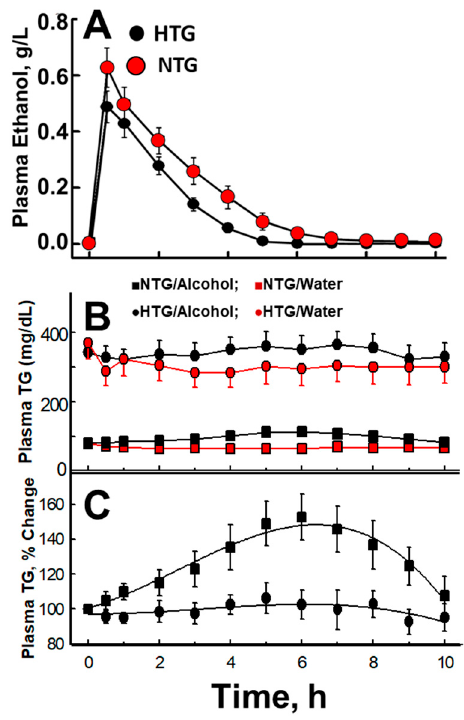
Figure 2. Plasma analytes among normotriglyceridemic (NTG) and hypertriglyceridemic (HTG) subjects after consuming 400 mL of 10% ethanol. ( A ) Ethanol concentrations, ( B ) Triglyceride (TG) concentration, and (C) % baseline triglyceride (TG); 6-h increases vs. baseline = 3% (HTG, p = 0.16) and 53% (NTG, p = 0.002). With permission [86].